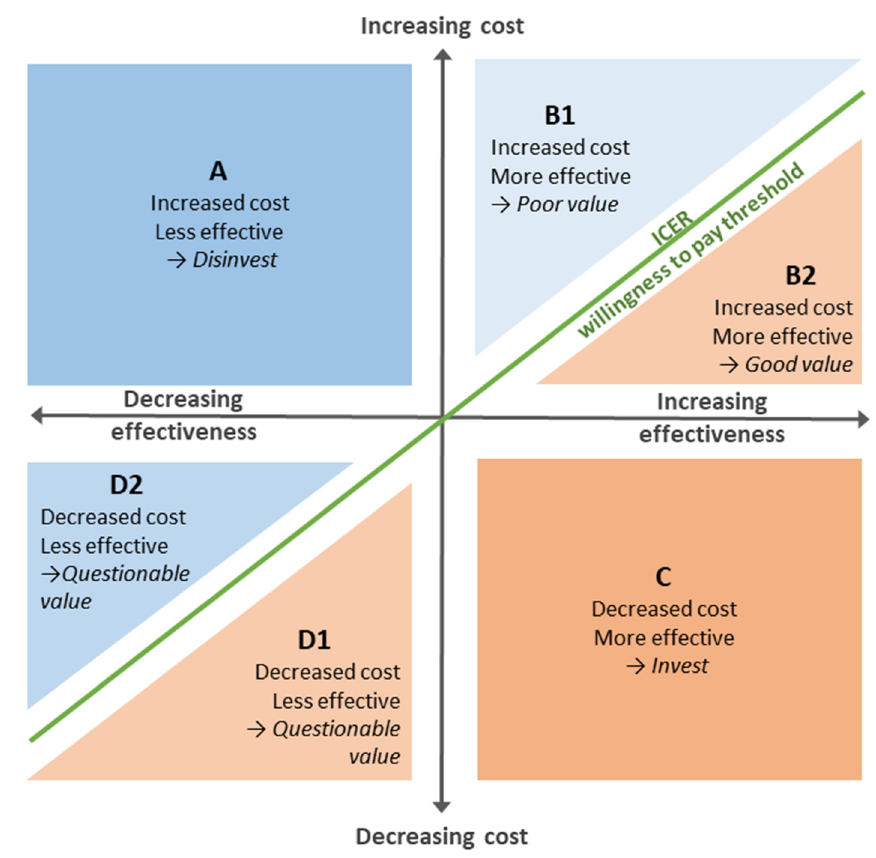
Figure 5. The cost-effectiveness plane with quadrants labelled to show how cost effectiveness study results can inform decision-making. results can inform